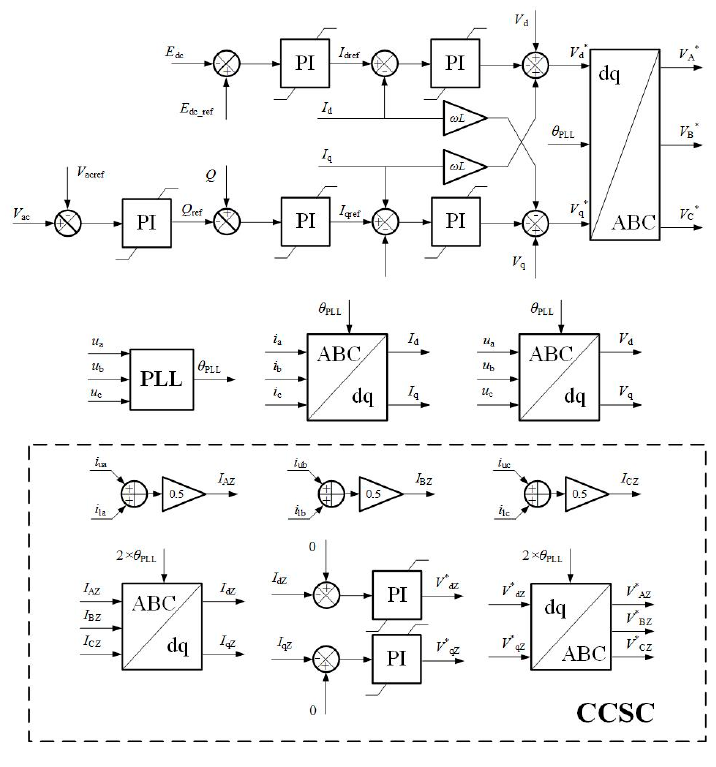
Figure 7. VSC dc and ac voltage control strategy.